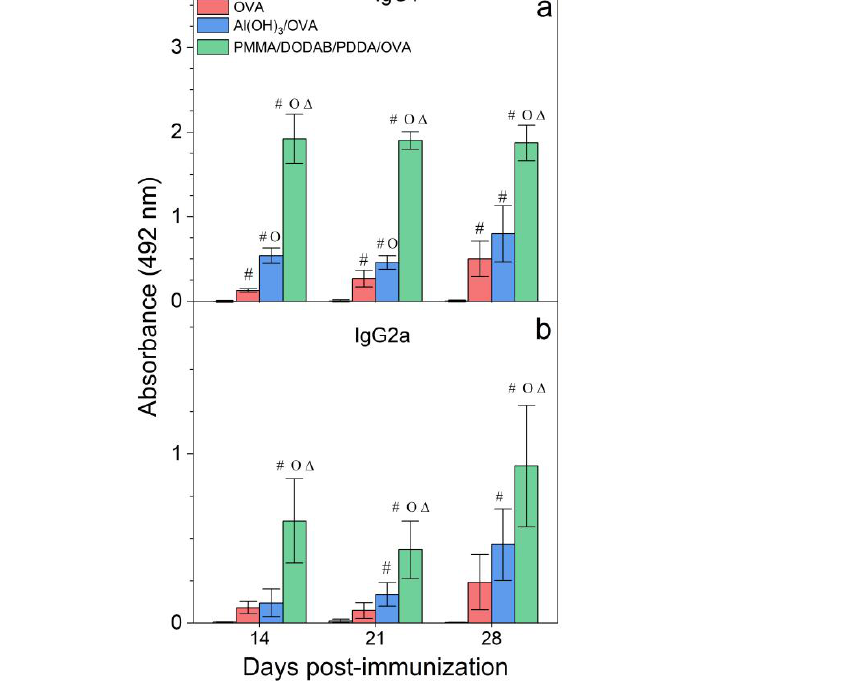
Figure 7. Humoral responses induced by OVA, Al(OH) 3 /OVA, or PMMA/DODAB/PDDA/OVA NPs. Mean absorbance at 492 nm ± standard deviation related to anti-OVA IgG1 ( a ) and IgG2a ( b ) antibodies production was determined over time after immunization of BALB/c mice from sera collected on days 14 and 21 post immunization (primary response) or on day 28 (secondary response). Primary IgG1 production was determined at 1/512 serum dilution, whereas the secondary one was obtained at 1/32,696 dilution. Primary IgG2a production was determined at 1/8 serum dilution, whereas the secondary one was obtained at 1/256 dilution. p < 0.05 compared to the naive group (#), p < 0.05 compared to the OVA group (o), p < 0.05 compared to the Al(OH) 3 /OVA group (∆).